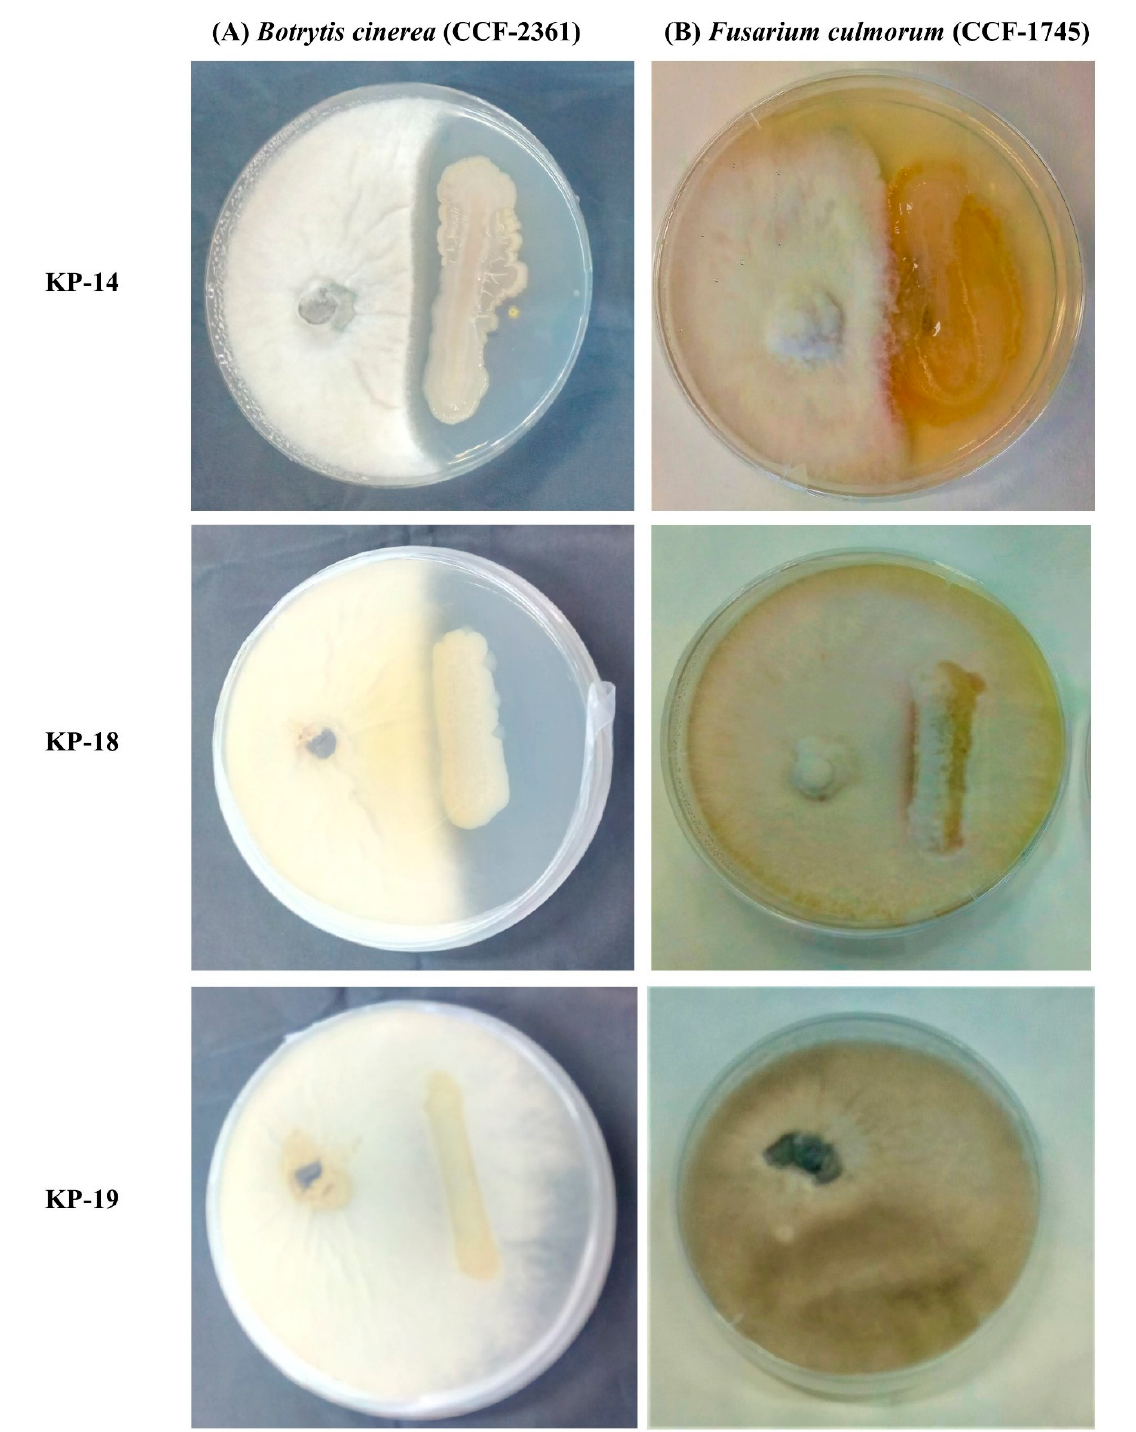
Figure 3. Antagonistic activity of selected isolates KP-14, KP-18, and KP-19 against ( A ) Botrytis cinerea (CCF-2361) and ( B ) Fusarium culmorum (CCF-1745).